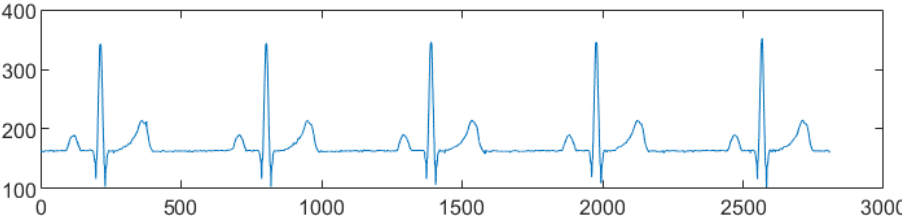
Figure 10. Signal reconstruction from pixels to samples (normal sinus rhythm, 60 bpm, II lead).